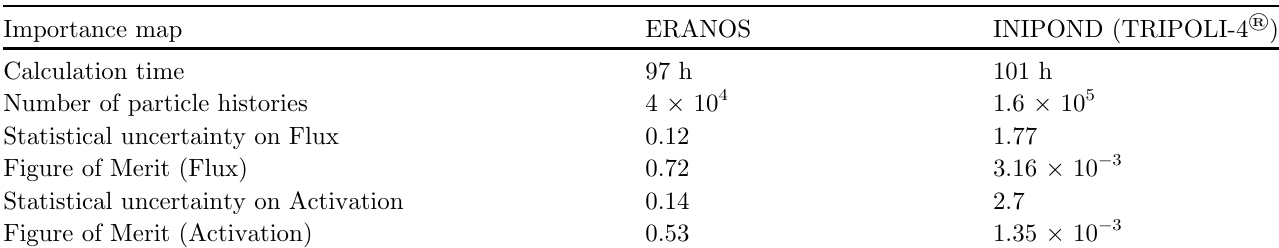
Table 4. Comparison of the performance of the ERANOS importance map and the INIPOND importance map. Importance